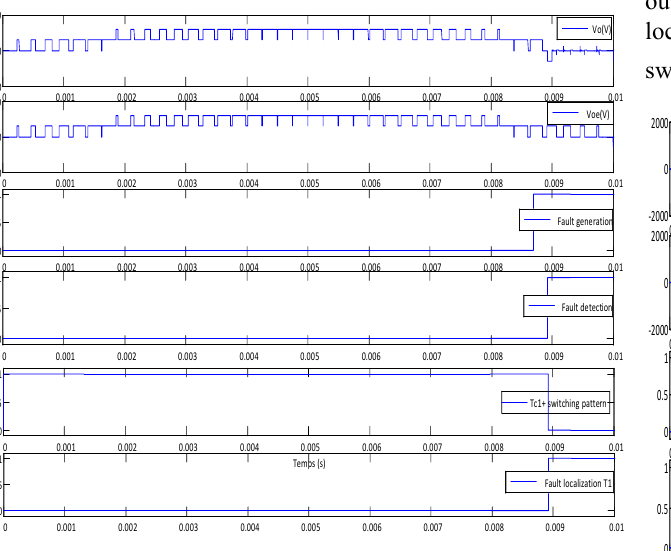
Fig.11: Simulation results when T1 is faulty (OCF in State 3).